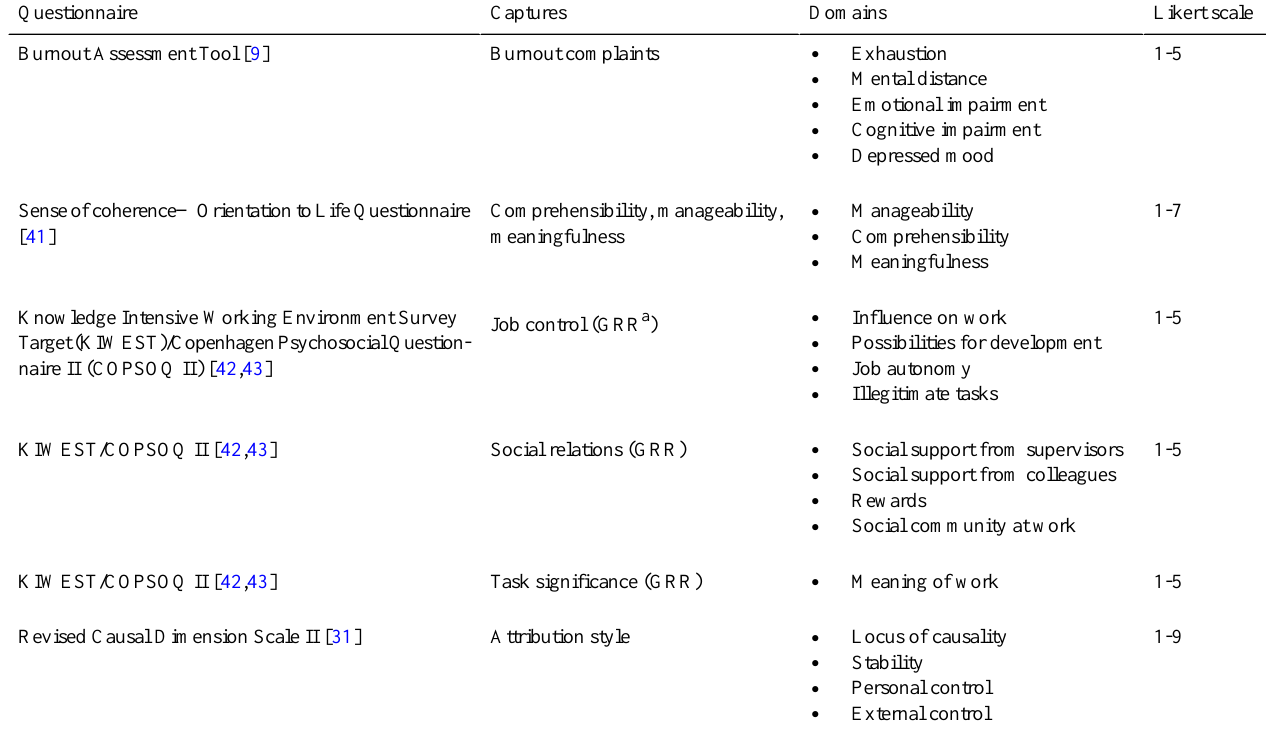
Table 1. Questionnaires to be used for the effect